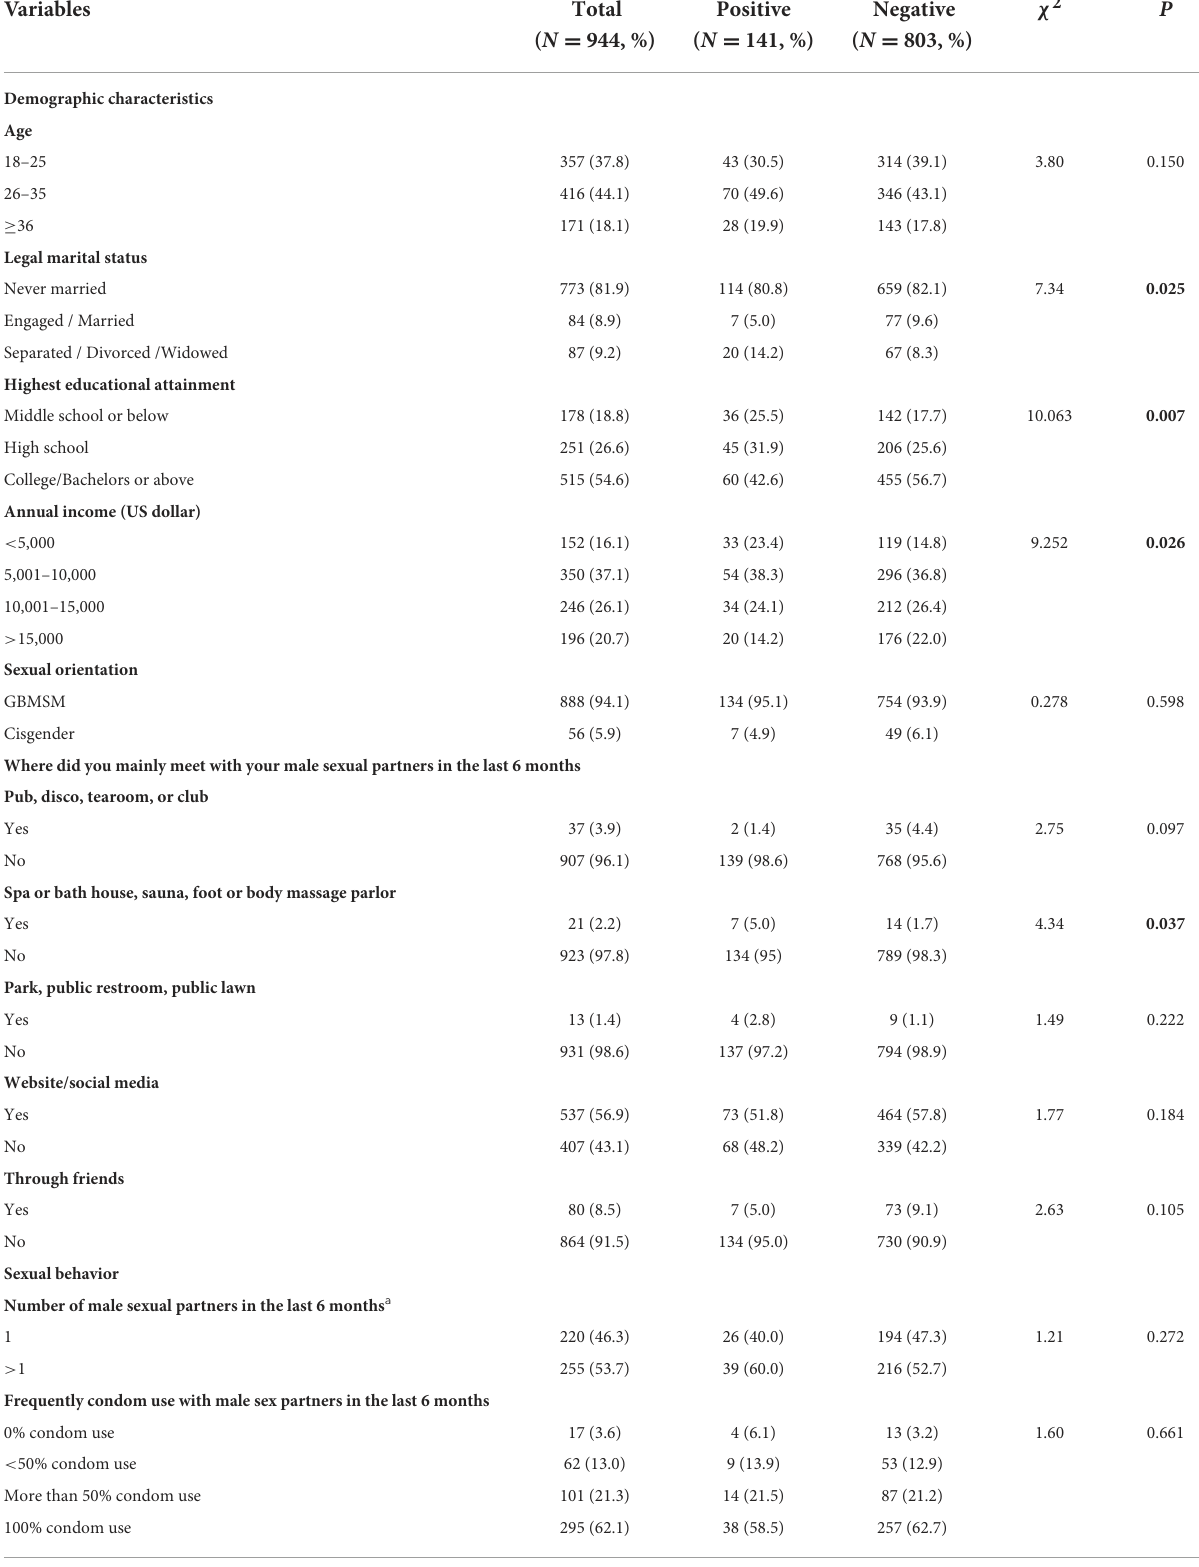
TABLE 1 Social-demographic and sexual behavioral characteristics among HIV-positive MSM in Guangdong Province from June 2020 to August 2021 ( N = 944).